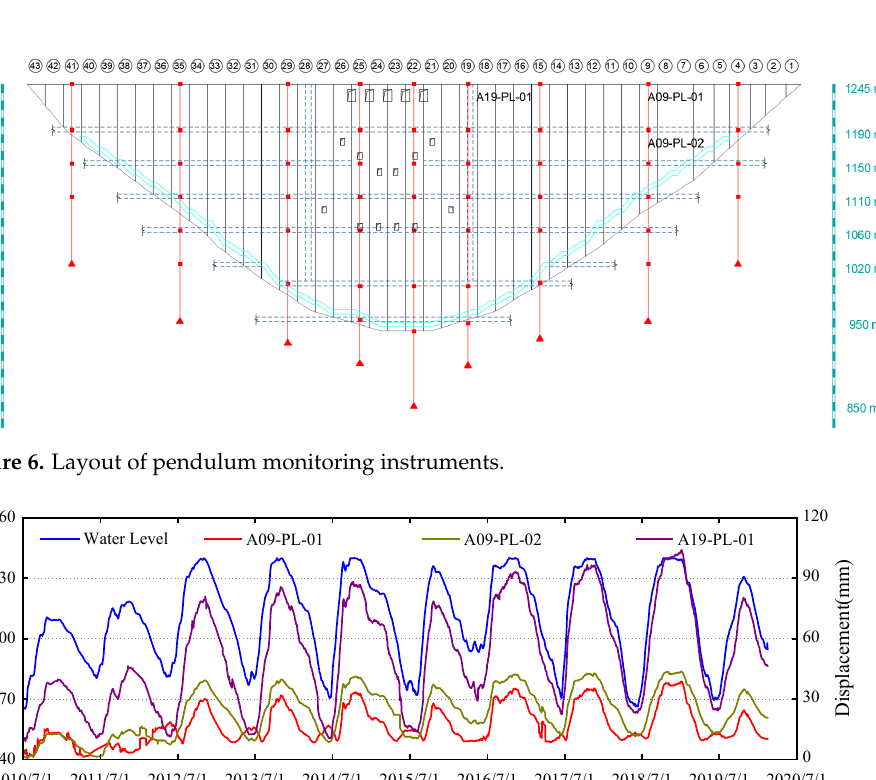
Figure 7. Evolution of the water level and the horizontal displacement at three measuring points.